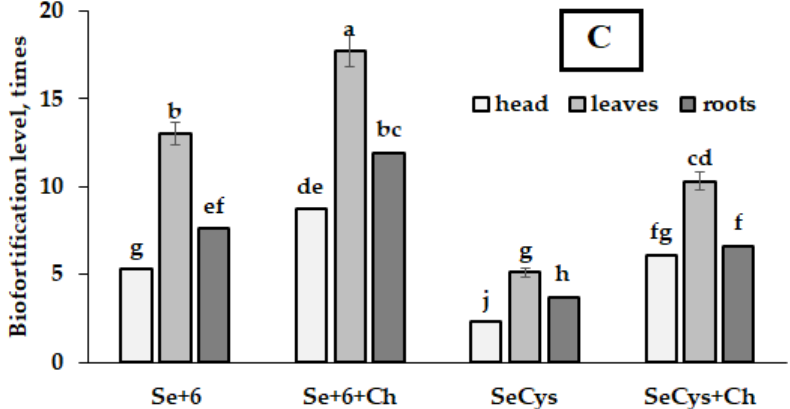
Figure 3. Selenium biofortification levels of the Savoy cabbage plant parts as affected by Se chemical form and Chlorella supply. Cultivars: ( A )—Vertu 1340; ( B )—Golubtsy; ( C )—Melissa. Values with the same letters do not differ statistically according to Duncan test at p < 0.05.